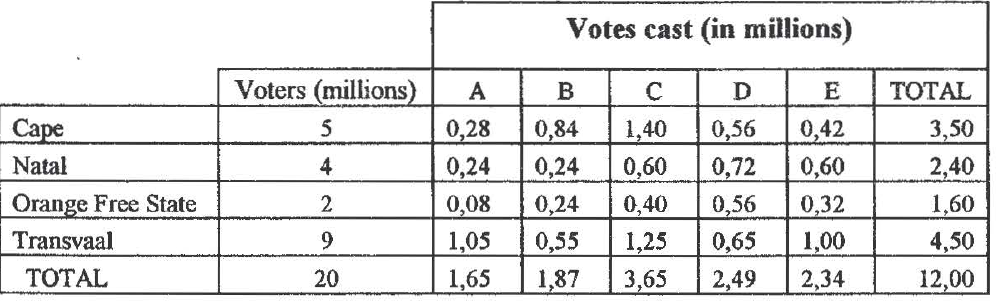
Table 1 :Example of voters and votes